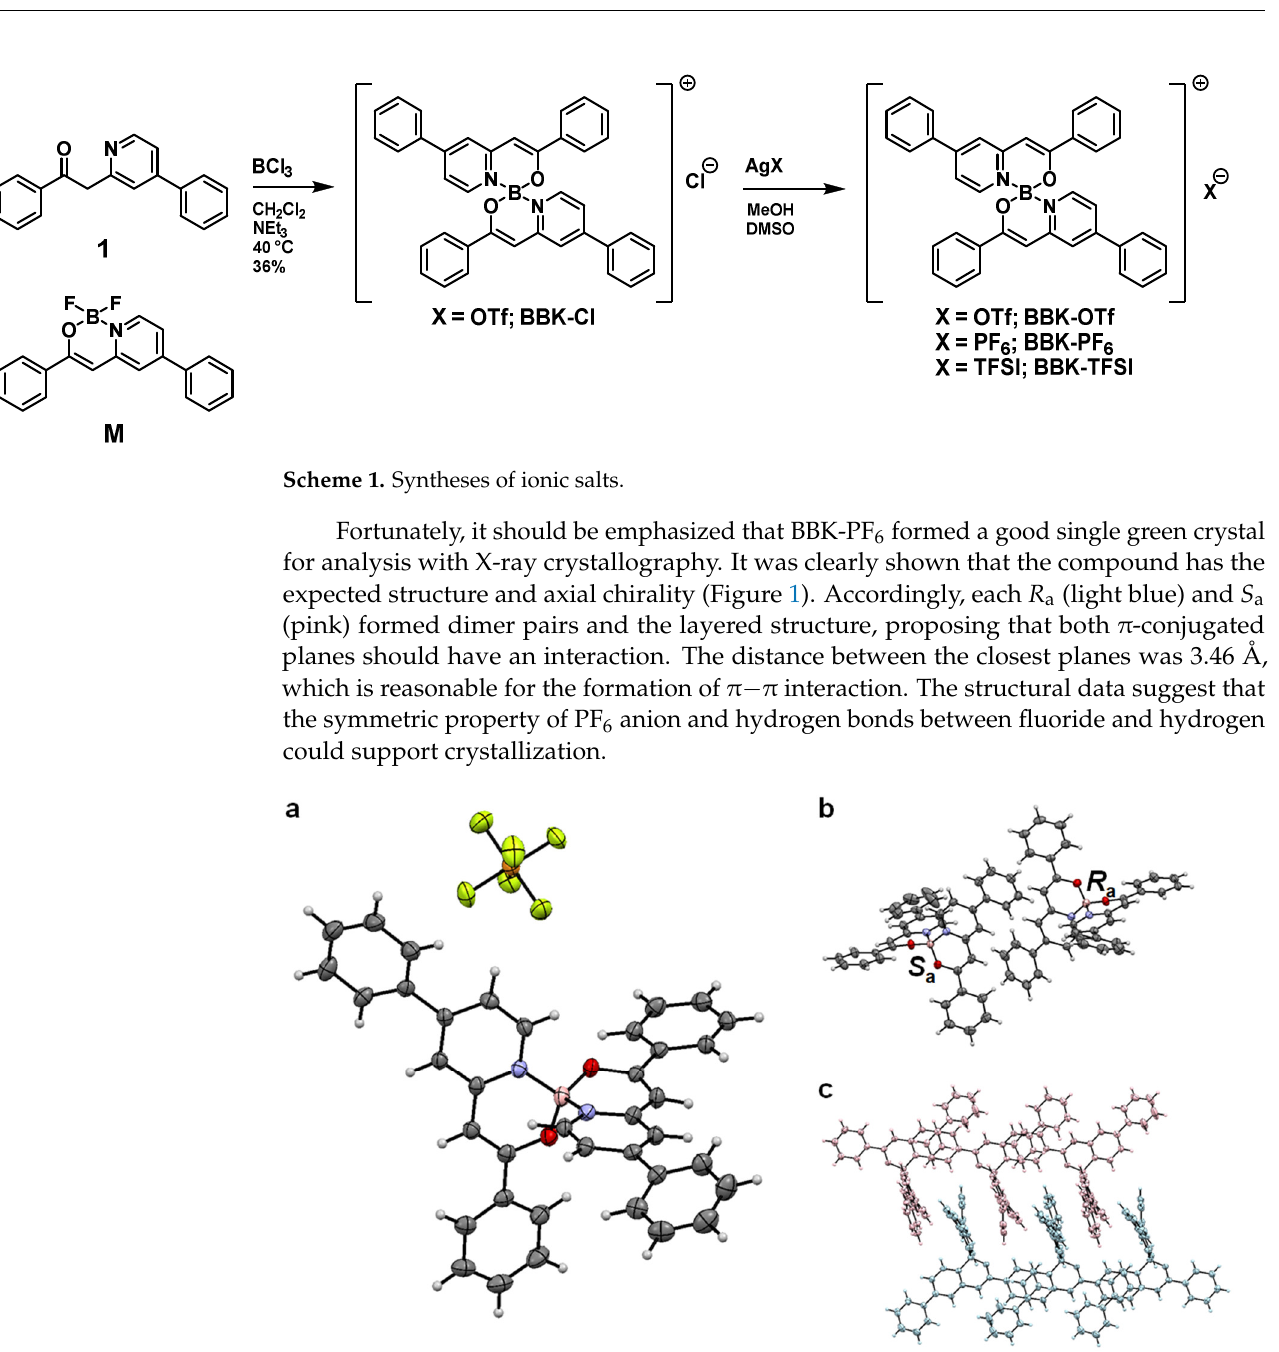
Figure 1. ( a ) ORTEP drawings of BBK-PF 6 (black—C; blue—N; red—O; white—H; light green—F; orange—P). ( b ) Axial chirality pair of the BBK unit; eliminated PF 6− . ( c ) Packing structure of chiral pair of the BBK unit; eliminated PF 6− (blue— R a , pink— S a ).